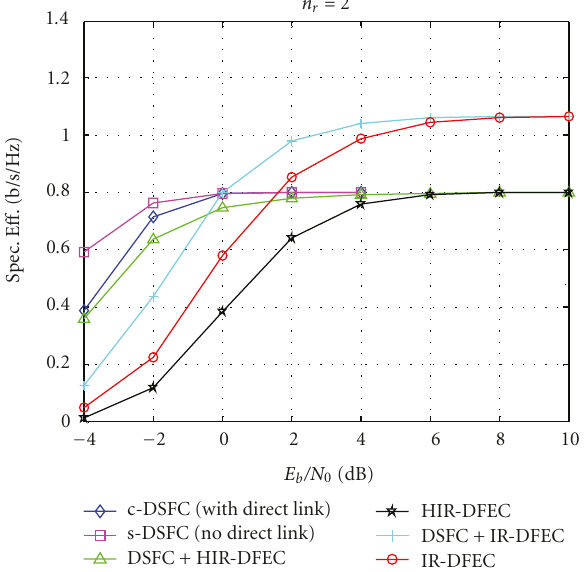
Figure 14: Spectral e ffi ciency versus E b /N 0-direct —modified D2— n d = 2, n r =